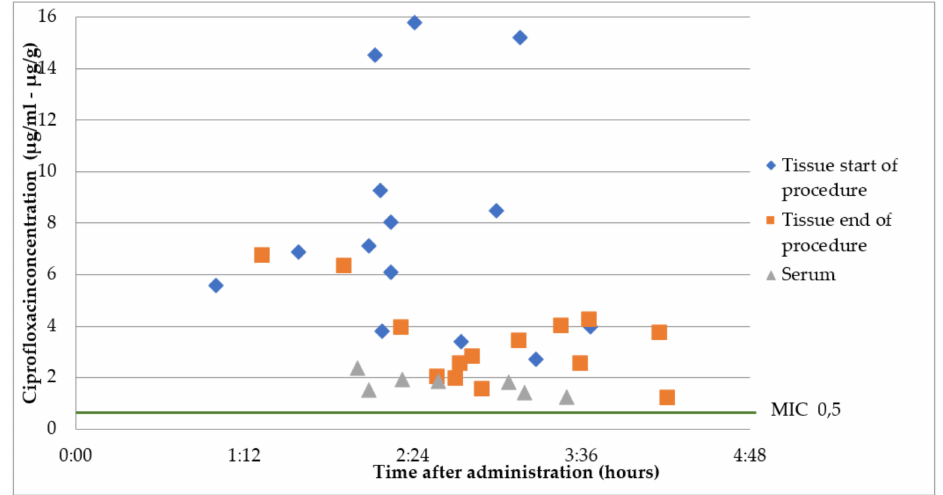
Figure 3. Ciprofloxacin concentrations in serum and prostate tissue after a single oral dose 2 h prior to surgery. Enterobacterales are considered susceptible to fluoroquinolones when MIC < 0.5 µ g/mL [7].